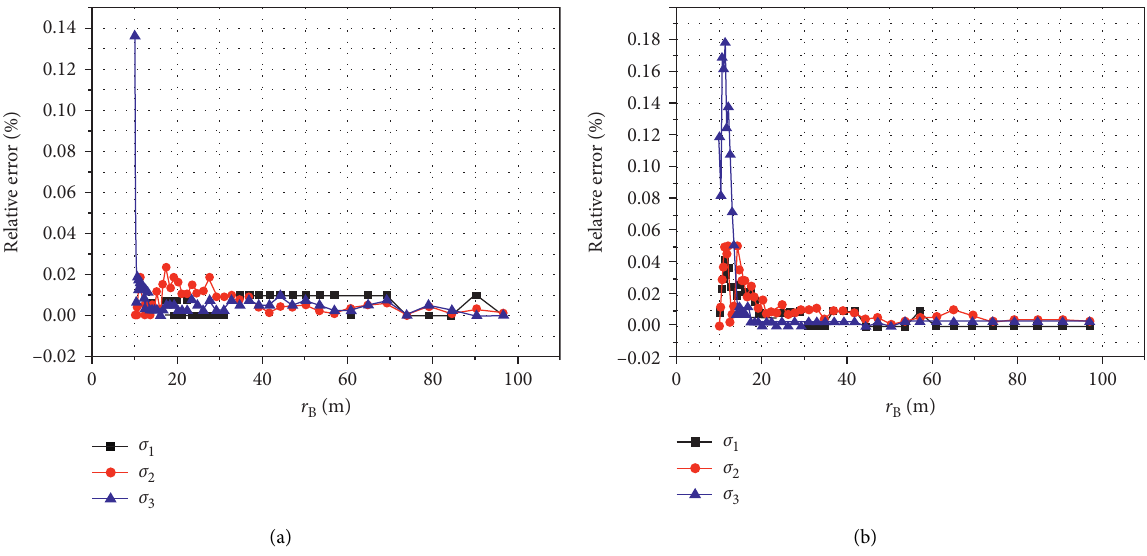
Figure 5: Relative errors of the final principal stresses: (a) associated case and (b) nonassociated